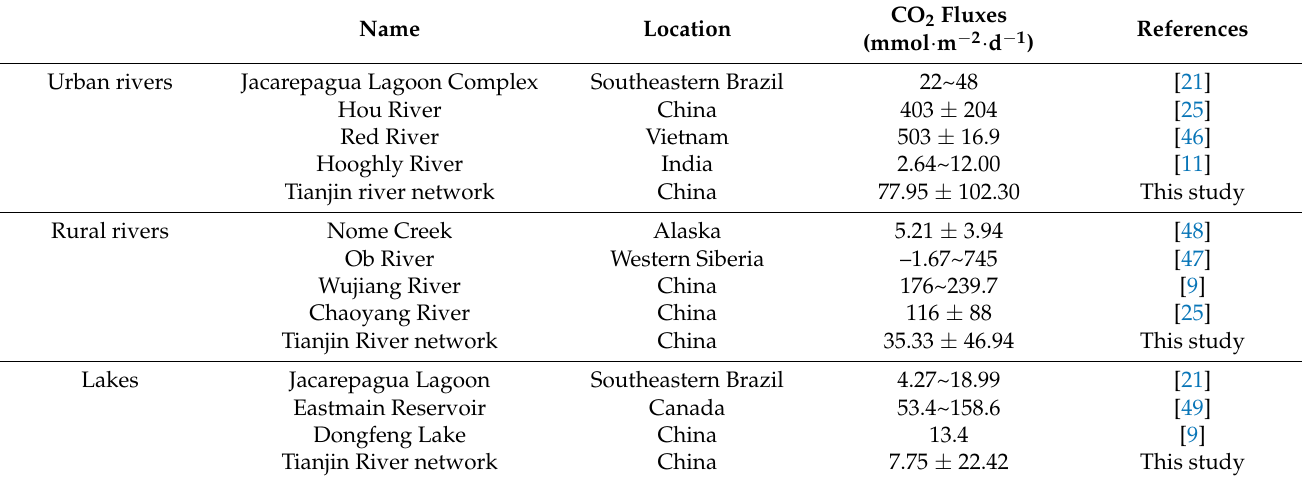
Table 3. Fluxes of CO 2 in other rivers/lakes.